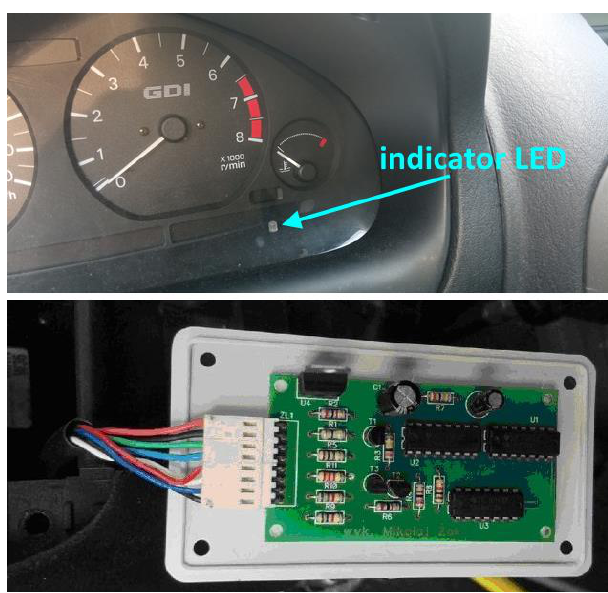
Fig. 7. Electronic circuit of the indicator and the location of its components